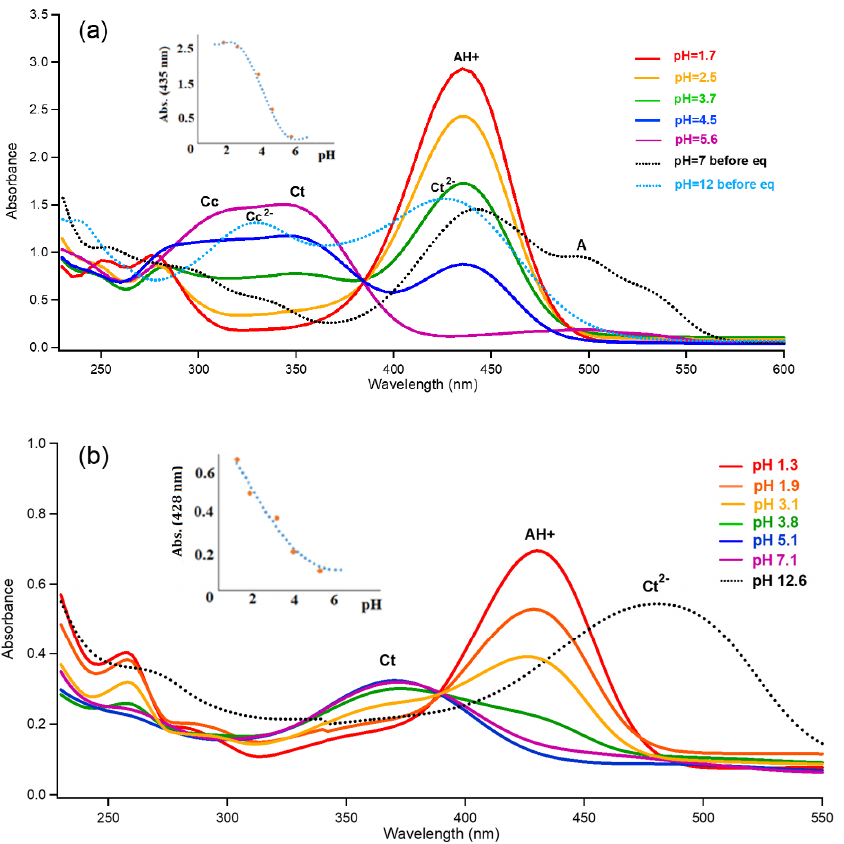
Figure 3. UV – vis spectra of flavyliums F1 and F2 and their CB mixtures in various pH levels. ( a ) On the F1 spectrum, 435 nm is assigned for AH + , 302 nm for Cc , 345 nm for Ct , 426 nm for Ct 2 − (dotted blue curve at pH = 12), and 498 nm for A (dotted black curve obtained immediately after dissolving flavylium ion in pH = 7); ( b ) on the F2 spectrum, 428 nm is assigned for AH + , 368 nm for Ct , and 478 nm for Ct 2 − . pKa ′ was found to be around 4.0 for F1 and 2.9 for F2 .